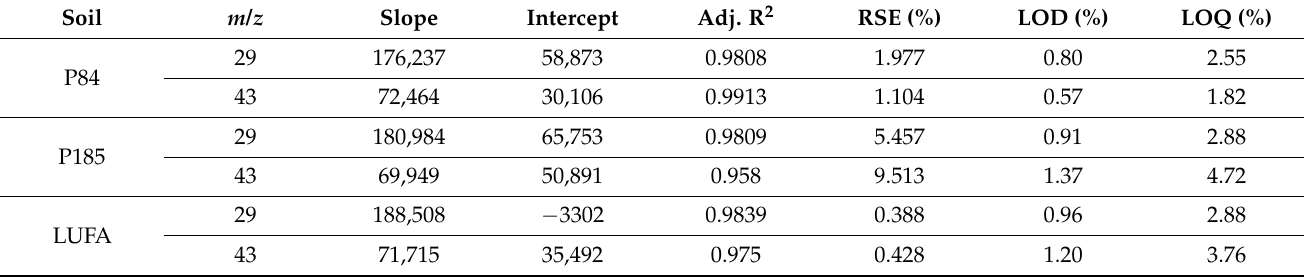
Figure 4. Calibration line for determination of PHB in HS5 soil by detection of degradation products with m/z 68; dashed line indicates 95% confidence interval. Table 3. Parameters of calibration lines for the determination of PLA micro-bioplastics in standard LUFA soil and two real soils by detection of degradation gas products with m / z 29 and